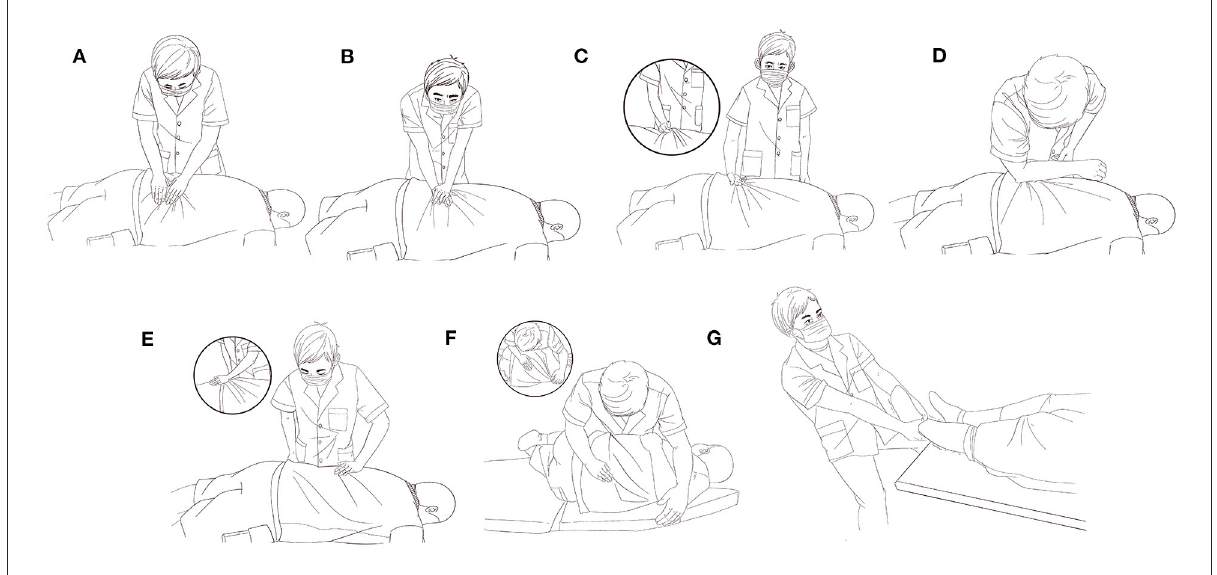
FIGURE2 Pictorial representation of TCM intervention. (A) Fingers pressing, (B) kneading, (C) Rolling, (D) Elbow pressing, (E) Pushing, (F) Spinal manipulation, (G)